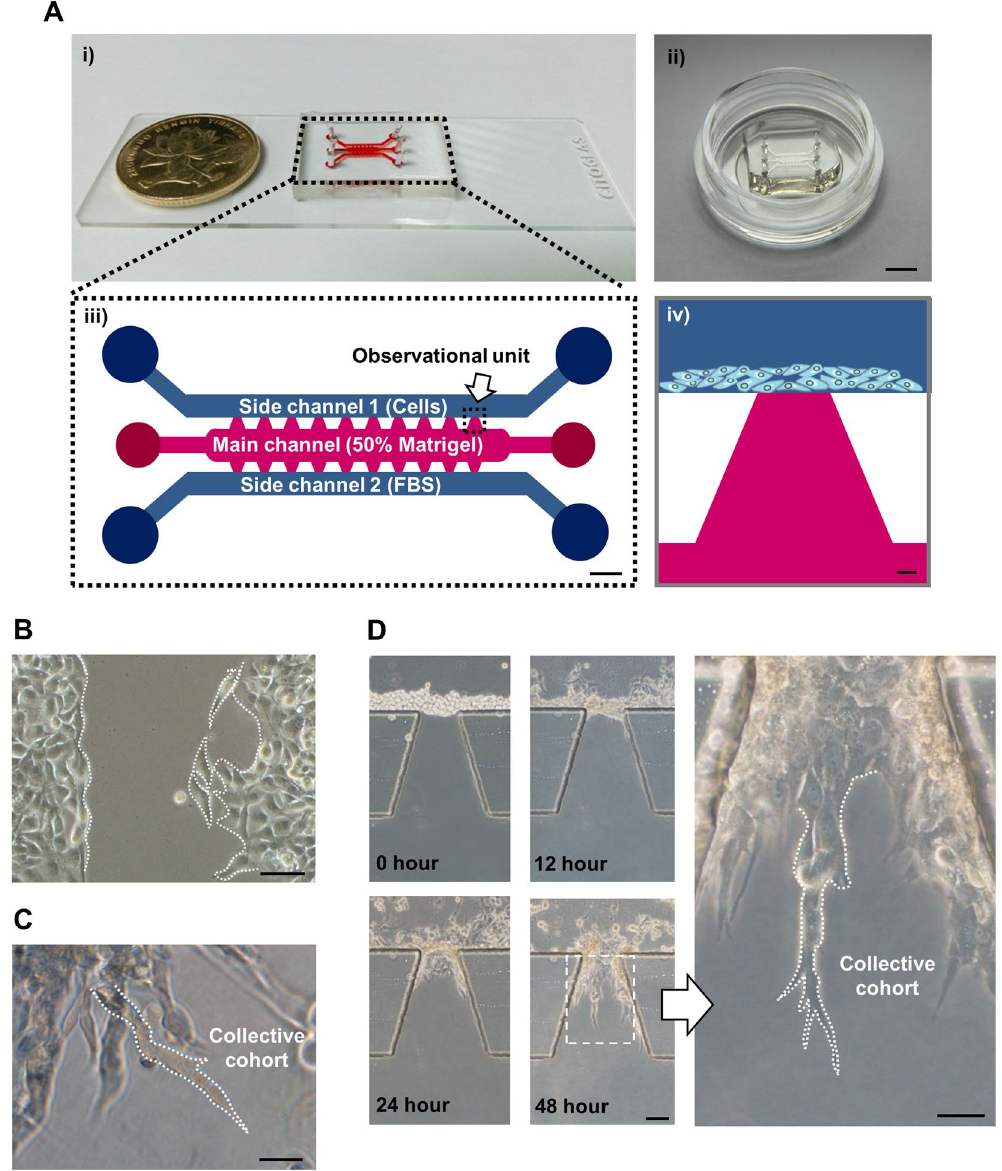
Figure 1. The fabrication of microfluidic chip and application for studying tumor invasion. ( A ) (i,ii) The images of microfluidic chip. Scale bar: 5 mm. (iii) Schematic of the microfluidic chip. The chip is composed of one central chamber (red) and two side channels (blue). The central chamber was filled with 50% matrigel. Cells with culture medium with 1% FBS were seeded in one of the side channels. Cell culture medium with 10% FBS was loaded to another side Chanel. A diffusion-based concentration gradient of FBS was formed between the side channels. Detailed parameters are illustrated in materials and methods. Scale bar: 500 μ m. (iv) The observation unit. Cancer cells in cell culture medium (contains 1% FBS) are seeded in one of the side channels. The central chamber is filled with 50% matrigel. Serum gradient is generated by the 10% FBS containing cell culture medium injected into the opposite side channel. Scale bar: 100 μ m. ( B ) Morphology of MDA-MB-231 cells in wound healing assay. ( C ) Morphology of MDA-MB-231 cells in 3D culture. ( D ) MDA-MB-231 cells were seeded in the side channel of the microfluidic chip. Images were taken at 0 hour, 12 hours, 24 hours and 48 hours respectively. Scale bar: 100 μ m. Arrow indicates the highlight of morphology of cell collective cohorts. Scale bar: 50 μ